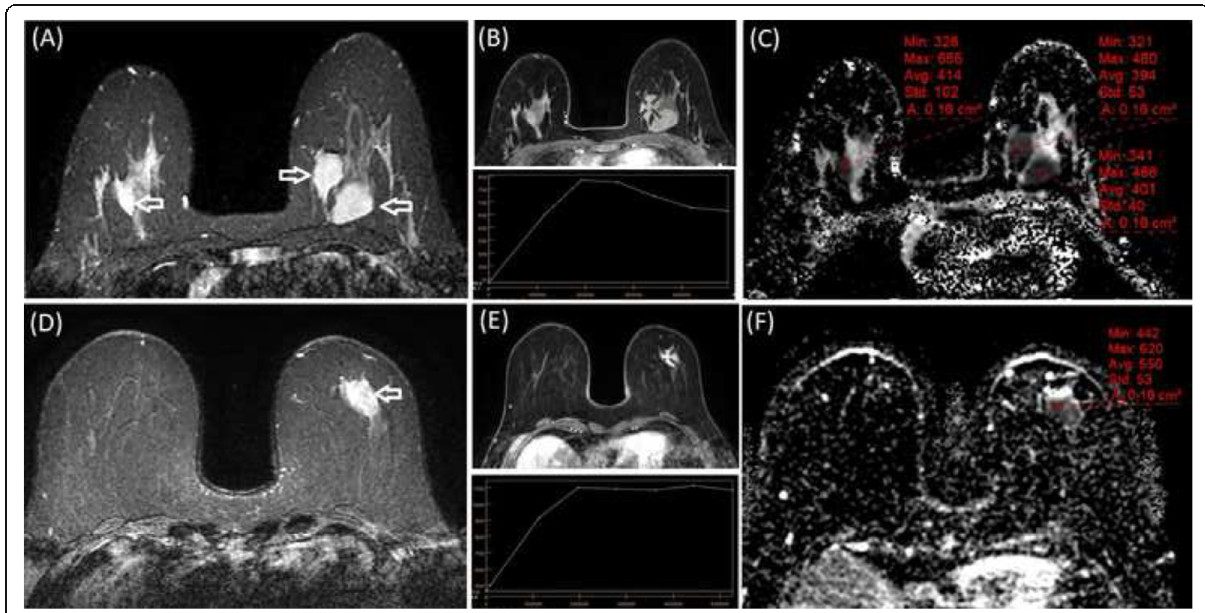
Fig. 3 MRI findings of hematological involvement of breast. Images of a 22-year-old woman diagnosed with granulocytic sarcoma show lesions in both breasts ( a – c ). Hyperintensity of lesions (arrows) is seen on the T2W image ( a ). Type 3 (wash-out) dynamic curve and contrast enhancement on contrast-enhanced T1-weighted image ( b ) are demonstrated. Hypointensity of lesions and low apparent diffusion coefficient (ADC) values can be seen due to diffusion restriction on the ADC map ( c ). MRI images of a 55-year-old woman diagnosed with marginal zone lymphoma in the left breast ( d – f ). Hyperintensity (arrow) is depicted on the T2W image ( d ). Type 2 (plateau) dynamic curve and contrast enhancement on contrast- enhanced T1-weighted image ( e ) are demonstrated. Hypointensity of the lesion and low ADC value are seen due to diffusion restriction on the ADC map ( f